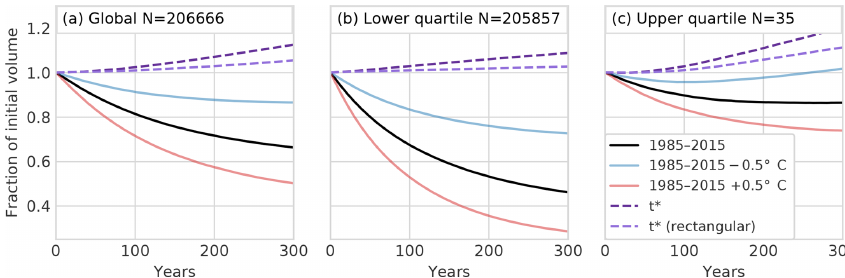
Figure 12. (a) Global glacier volume change under various climate scenarios (1985–2015 climate with three temperature biases and climate at t ∗ which, for each glacier individually, represents a theoretical equilibrium climate) and model configurations (rectangular bed instead of the mixed default), plotted as a fraction of the initial volume. (b, c) Volume changes of all glaciers making up for the first and last quartile of the sorted cumulative total